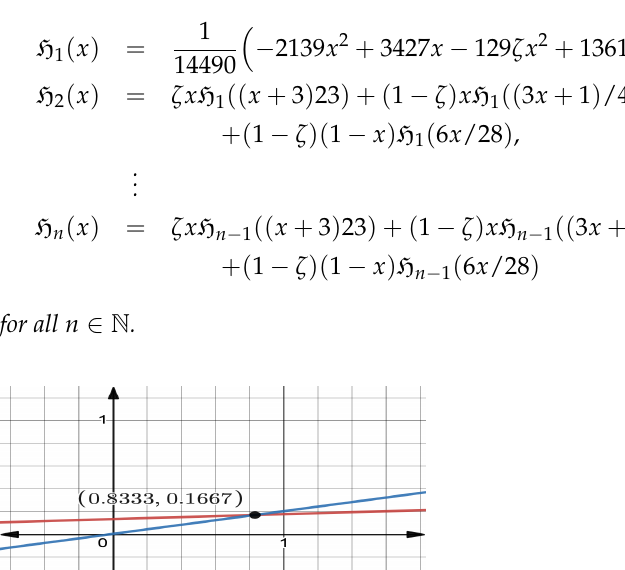
( x ) = x + 1 (red) and G γ 23 1